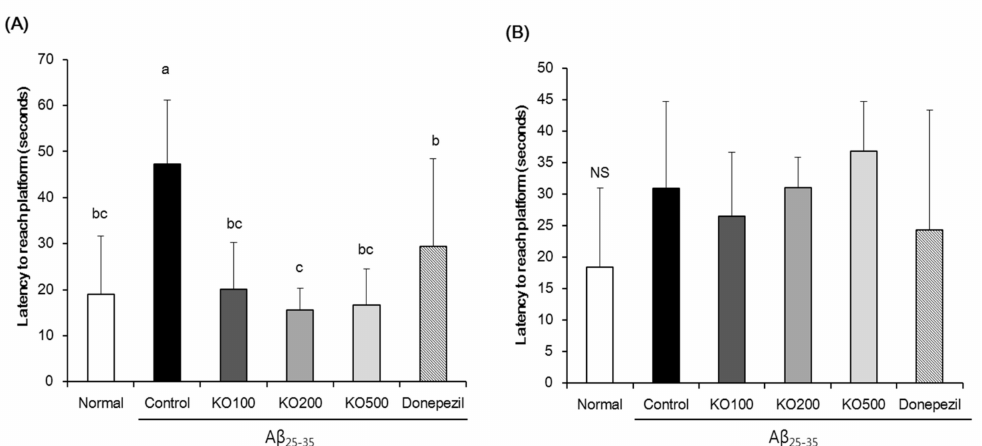
Figure 6. E ff ect of krill oil (KO) on on escape latency to the hidden platform ( A ) and exposed platfrom ( B ) in Morris water maze test. Normal, injection of saline solution + oral administration of water; Control, injection of A β 25–35 + oral administration of water; KO100, injection of A β 25–35 + oral administration of KO at 100 mg / kg / day; KO200, injection of A β 25–35 + oral administration of KO at 200 mg / kg / day; KO500, injection of A β 25–35 + oral administration of KO at 500 mg / kg / day; Donepezil, injection of A β 25–35 + oral administration of donepezil at 5 mg / kg / day. Values are represented as means ± SD. a–c Means with the di ff erent letters are significantly di ff erent ( p < 0.05) by Duncan’s multiple range test ( n = 8). b,c Means with the same letters such as b and c are not significantly di ff erent ( p < 0.05) by Duncan’s multiple range test. NS,